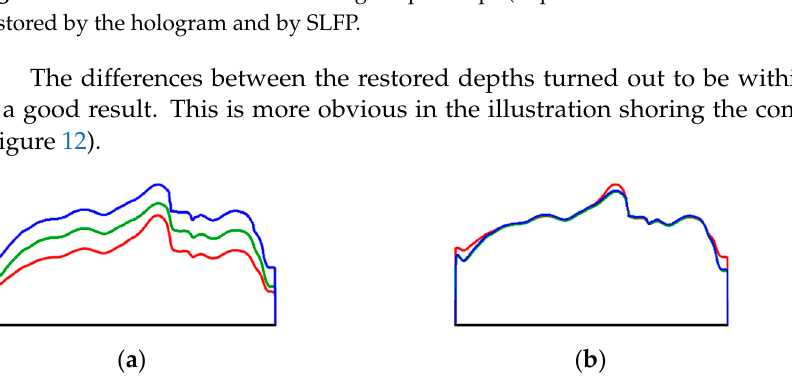
Figure 12. Profiles of the central region of the depth map: blue—initial (Figure 2d), green—restored by the hologram (Figure 8), red—restored by SLFP (Figure 10); ( a ) for clarity, the profiles are shifted along the vertical direction; ( b ) the profiles are